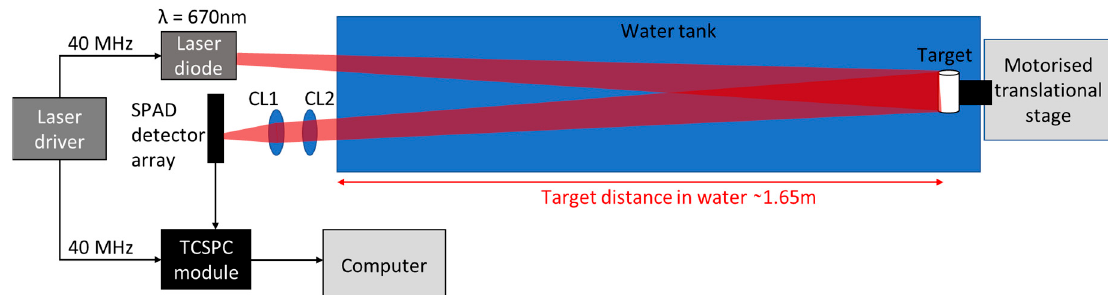
Figure 1. Schematic of the experimental setup. The system comprised a pulsed laser diode source with central wavelength 670 nm, a SPAD detector linear array, and dedicated TCSPC electronics. The scan was performed by moving the target over the vertical direction with a motorized translational stage, and the light scattered by the target was collected by using two cylindrical lenses (CL1 and CL2).